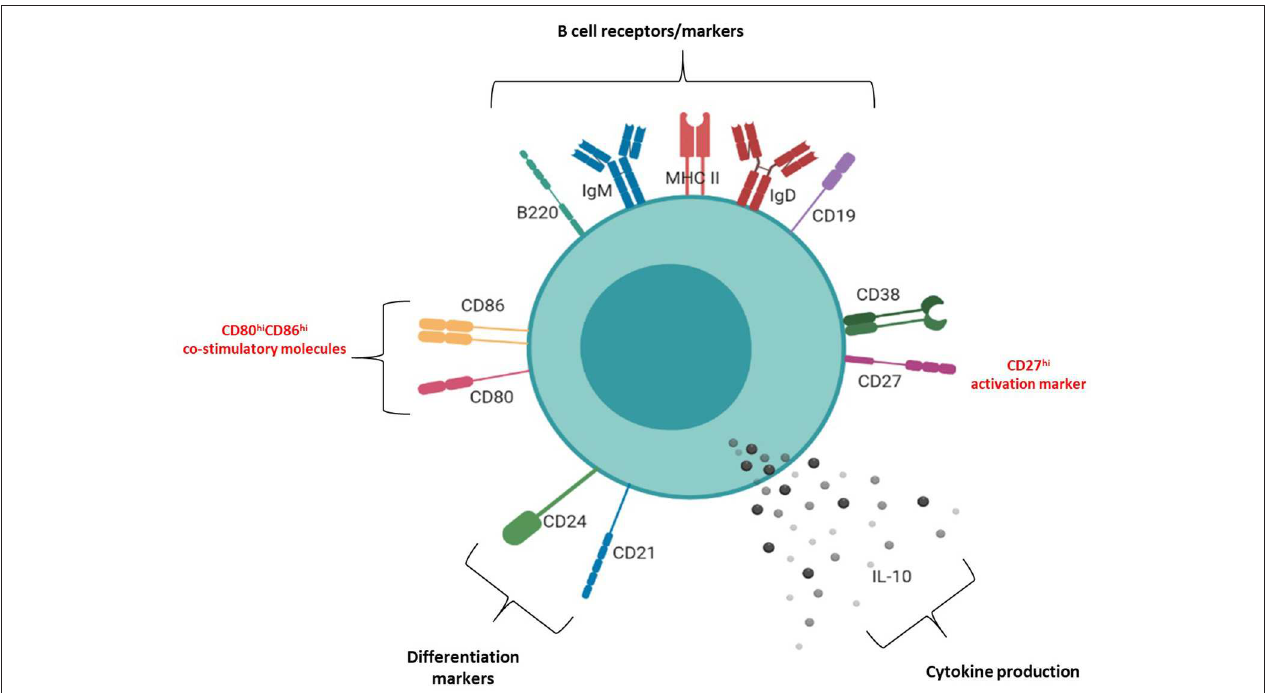
FIGURE 6 | Phenotypic structure of an IL-10 + uterine B cell at peri-implantation. Schematic diagram of the phenotypic markers expressed by uterine IL-10 + B cells at peri-implantation, including B cell receptors and markers (CD19, B220, IgM, IgD, MHC II), activation markers (CD27, CD38), differentiation markers (CD21, CD24), co-stimulatory molecules (CD80, CD86), and IL-10 cytokine